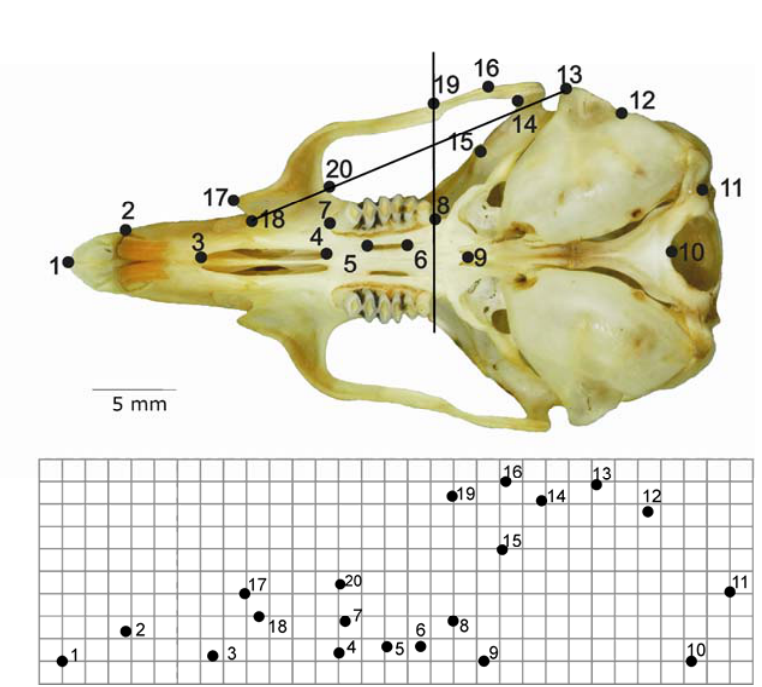
F IGURE 2. Landmarks positioned on the ventral view of a Meriones persicus skull specimen was originated from Baluchistan (Pakistan) from the collection of the Smithsonian Natural Museum of Natural History (cat. # 411093). Grid corresponds to the consensus shape